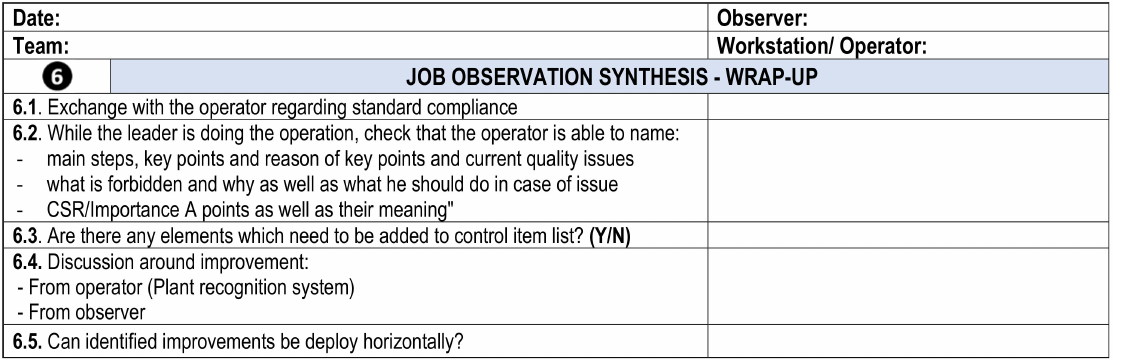
Figure 9. Form for JobObservation